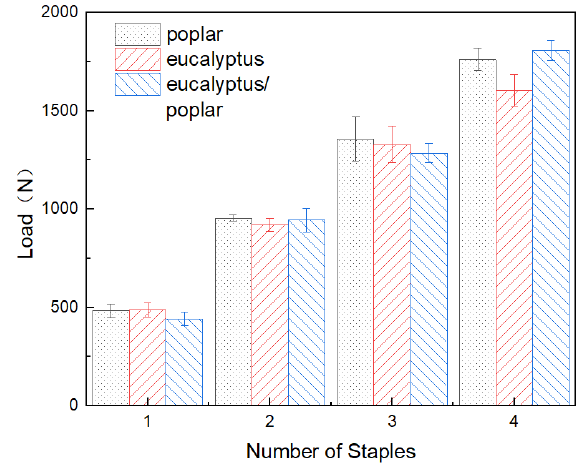
Figure 9. Lateral holding load histogram.